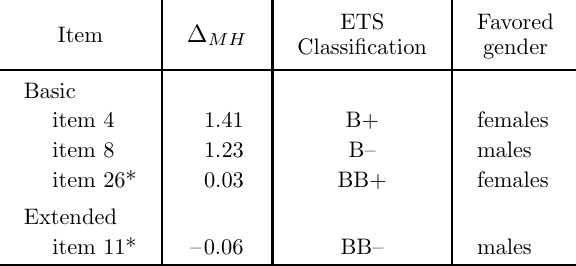
“New” Matura exam items flagged as DIF ETS Favored Item ∆ MH